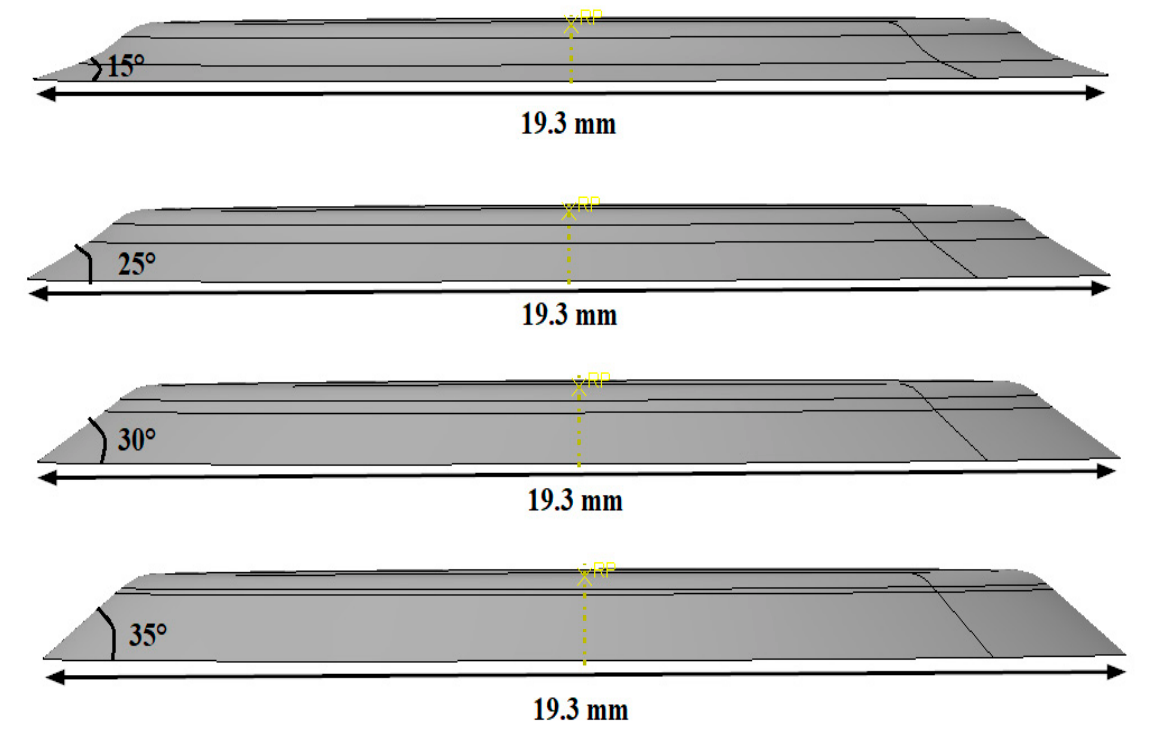
Figure 20. CZ10 cutting tool in relation to different diameters the cutting blade.